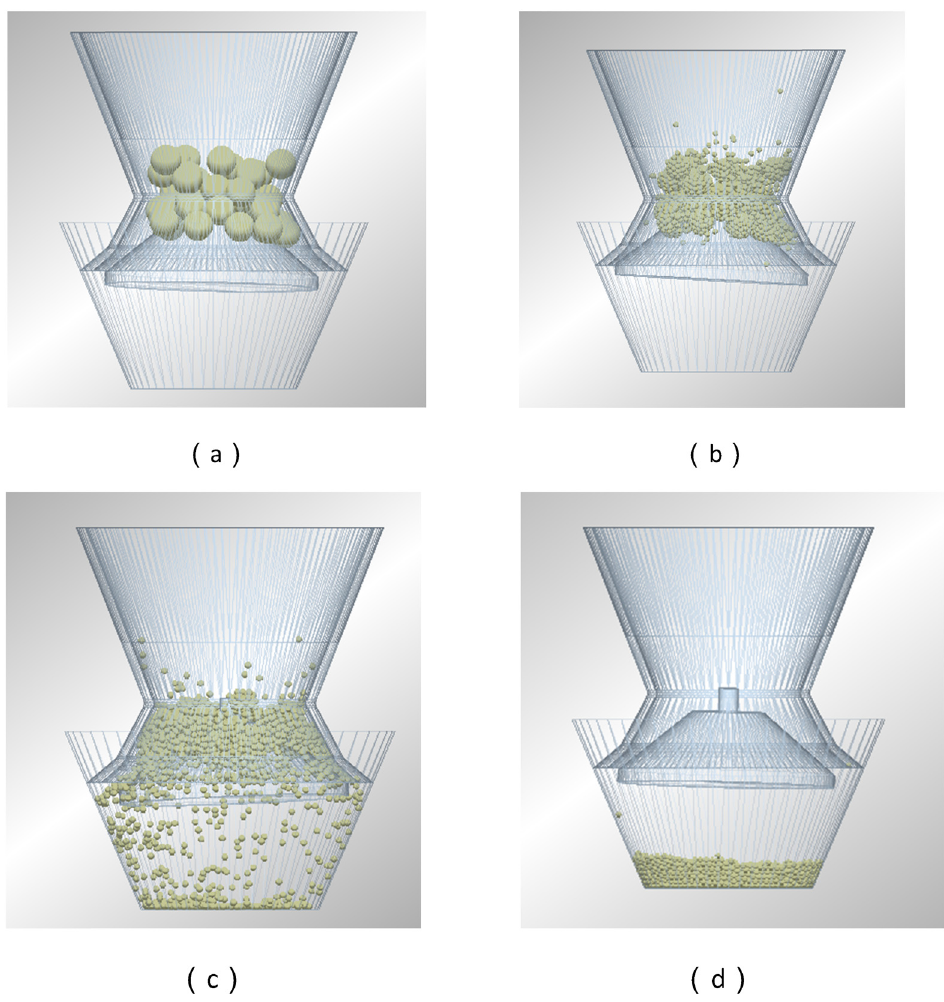
Figure 4: Simulation picture of particle breakage. ( a ) Pre - particle replacement, ( b ) after particle replacement, ( c ) before particle crushing and ( d ) after particle